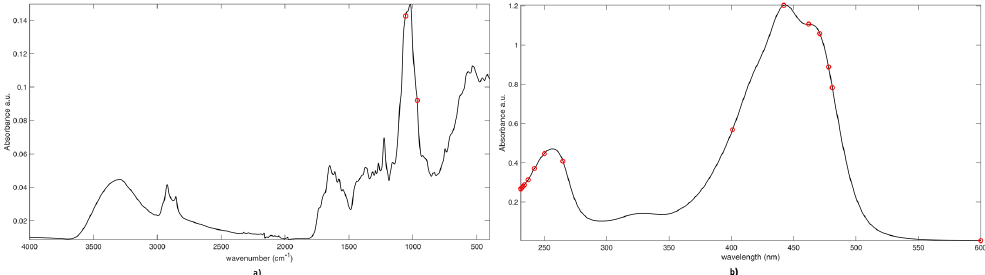
Figure 4. SO-CovSel-LDA Analysis. Graphical representation of variables selected on a ) IR block; and, b ) UV block. Legend: Black line: Mean Spectrum. Red Circles: Selected variables .